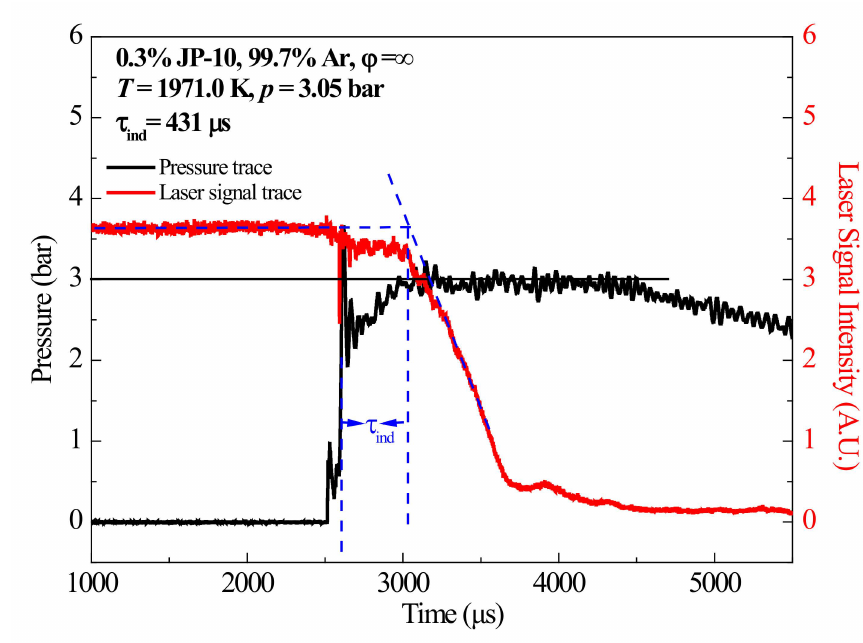
Figure 5. Typical pressure and laser signal traces for RP-3 measured in the present